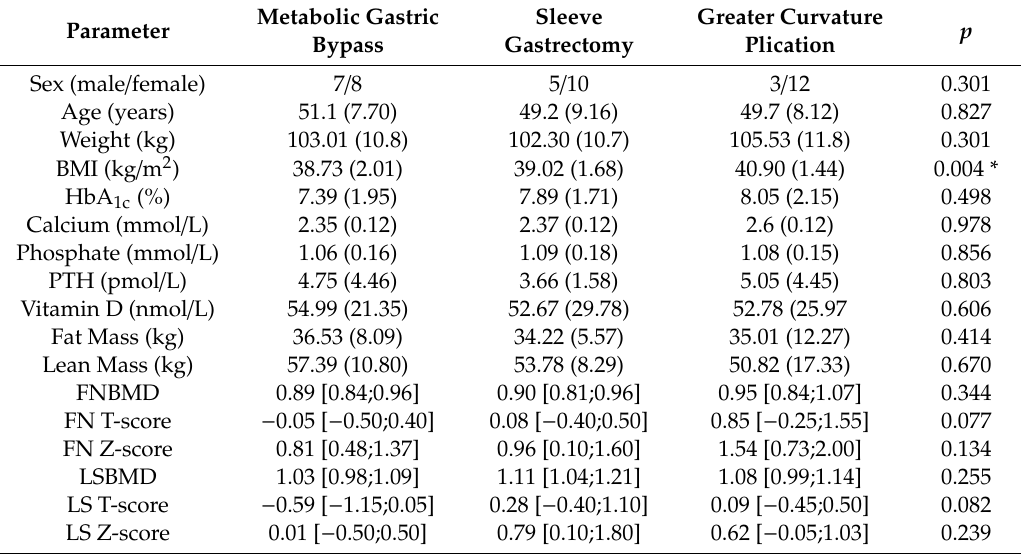
Table 1. Patient’s baseline characteristics.